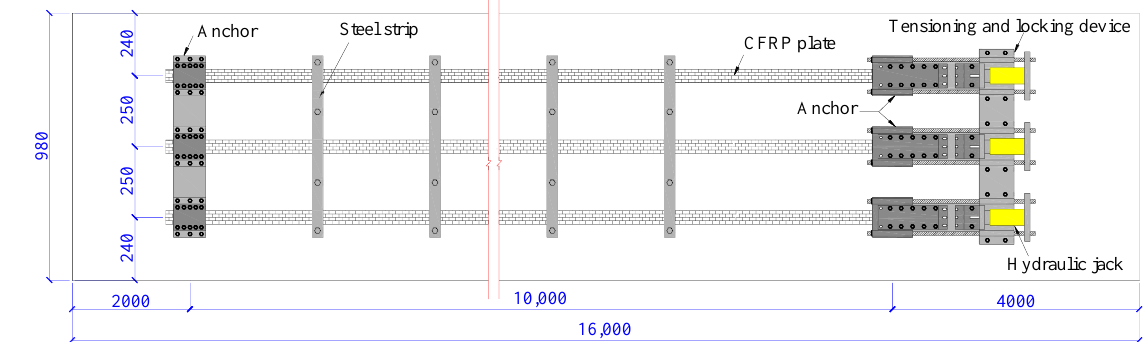
Figure 6. Schematic diagram of the prestressing of CFRP plates.